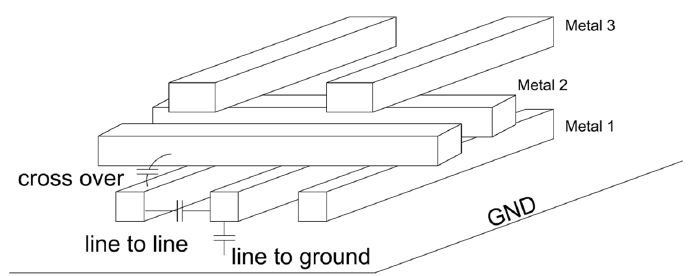
Figure 5. Schematic of interconnect capacitance model. Line to line, line to ground, and cross-over capacitance are shown accordingly.